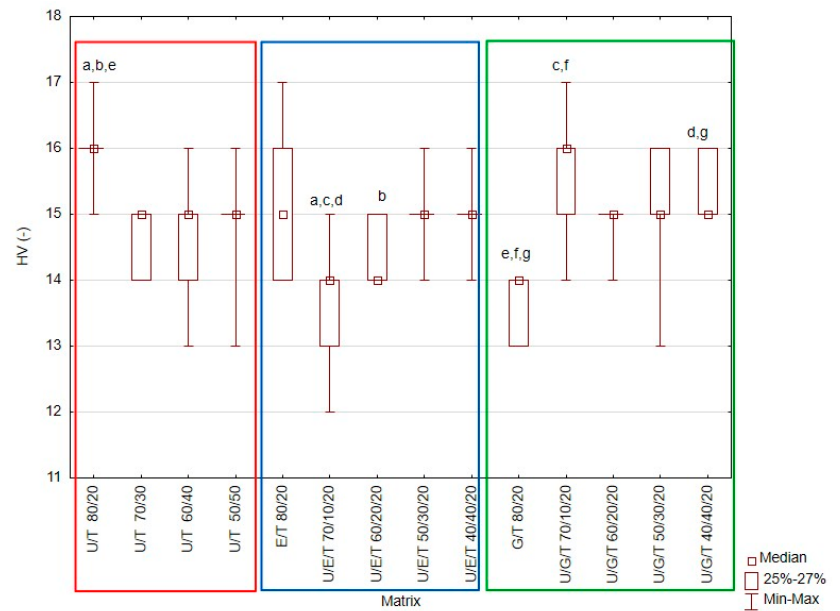
Figure 4. Box-and-whisker plot of Vickers hardness (HV) of tested materials. For variables with the same letter (a–g), the difference is statistically significant ( p ≤ 0.05).